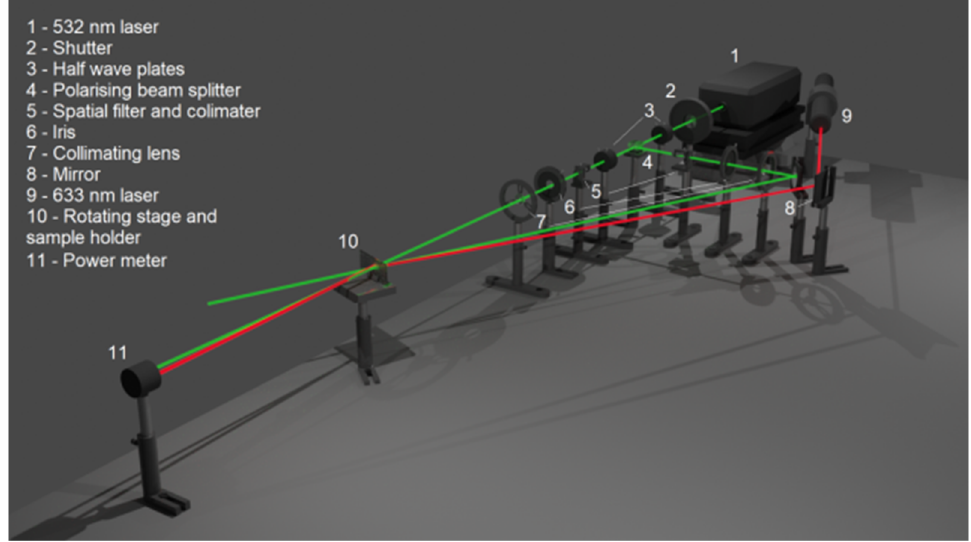
Figure 5. Holographic recording set-up.